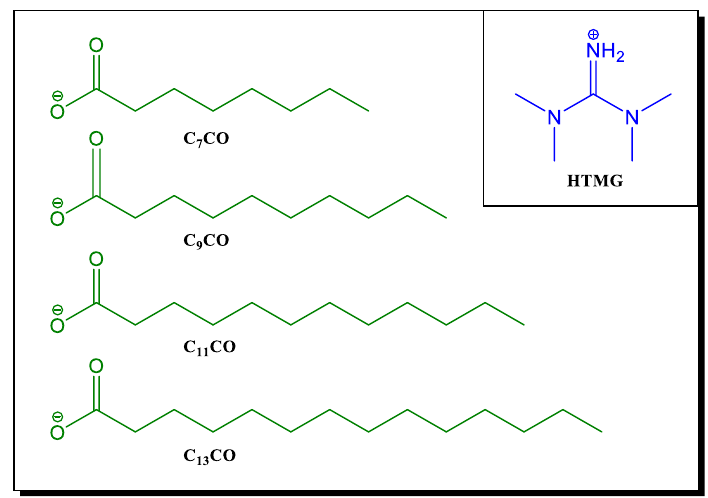
Figure 1. Carboxylate anions (FA, in green), obtained from the natural fatty acids, and tetramehyl guanidinium cation (in blue) components of the prepared fatty acids protic ionic liquids (FA-PILs).